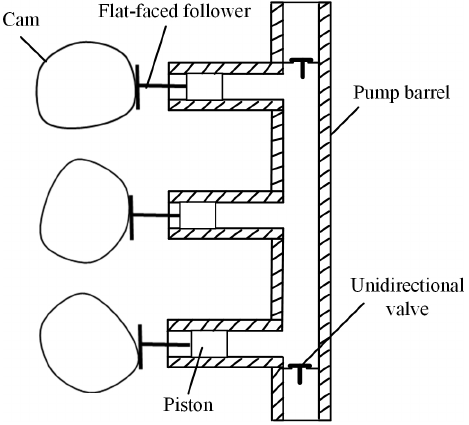
Figure 1. Structural diagram of the piston